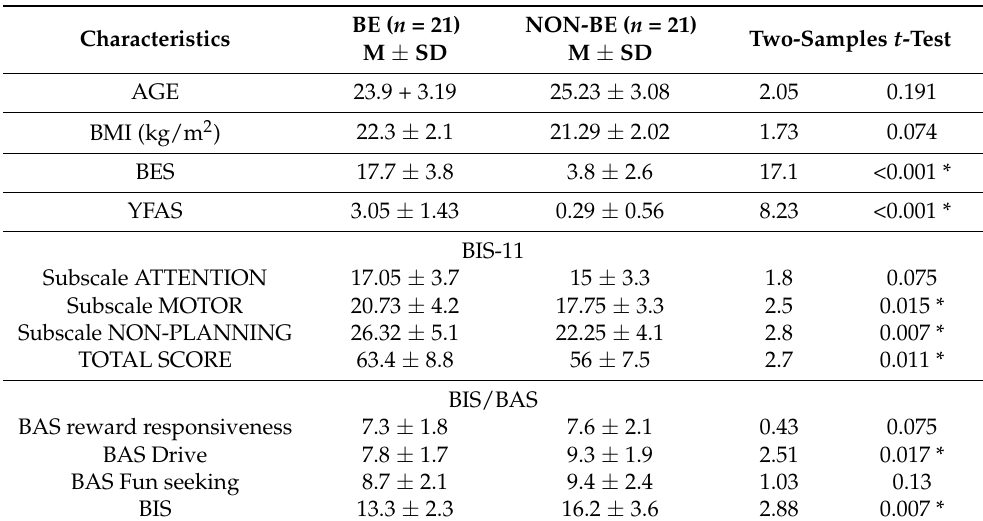
Table 1. Descriptive characteristics: between-group comparisons for age, body mass index and self-report measures.